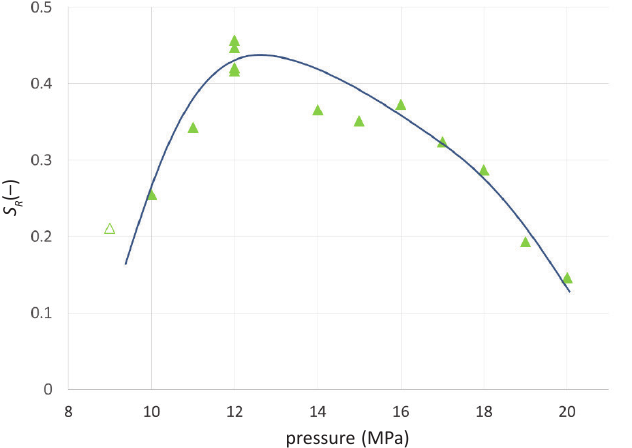
Fig. 7 – Effect of pressure on selectivity of diastereomeric salt formation. Reaction conditions: 0.5 molar ratio at 40 °C for 1 h. Empty symbols indicate wet raffinates. The line is to guide the eye.